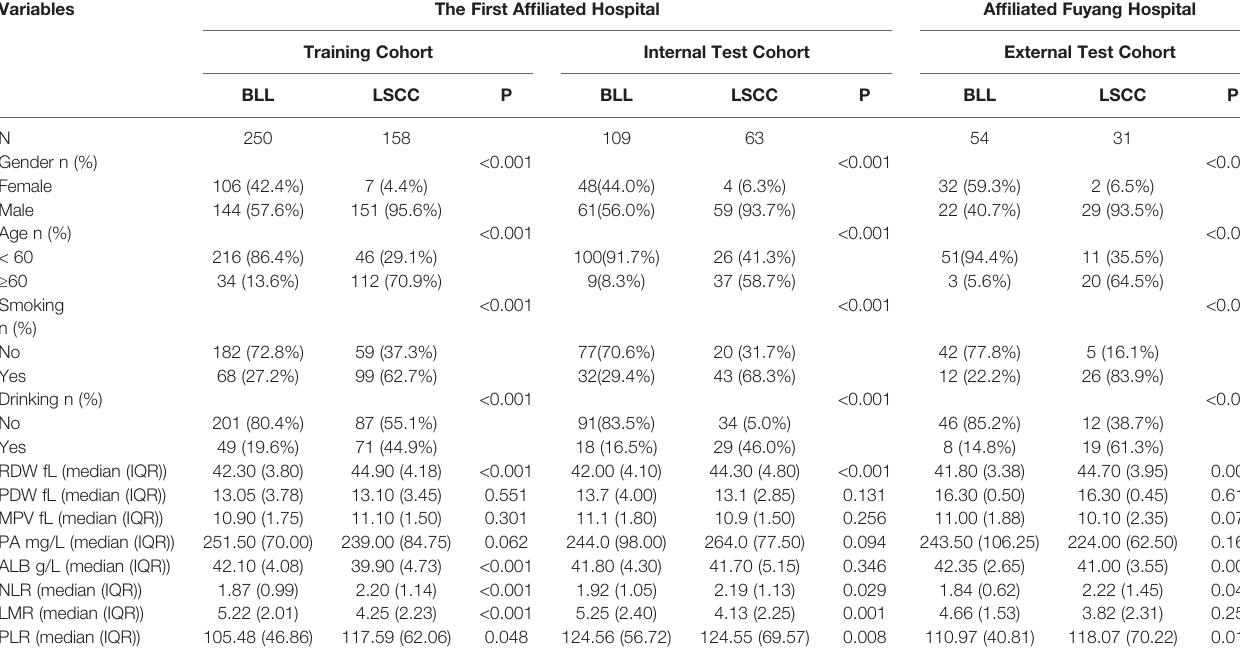
TABLE 2 | Comparison of variables between LSCC group and BLL